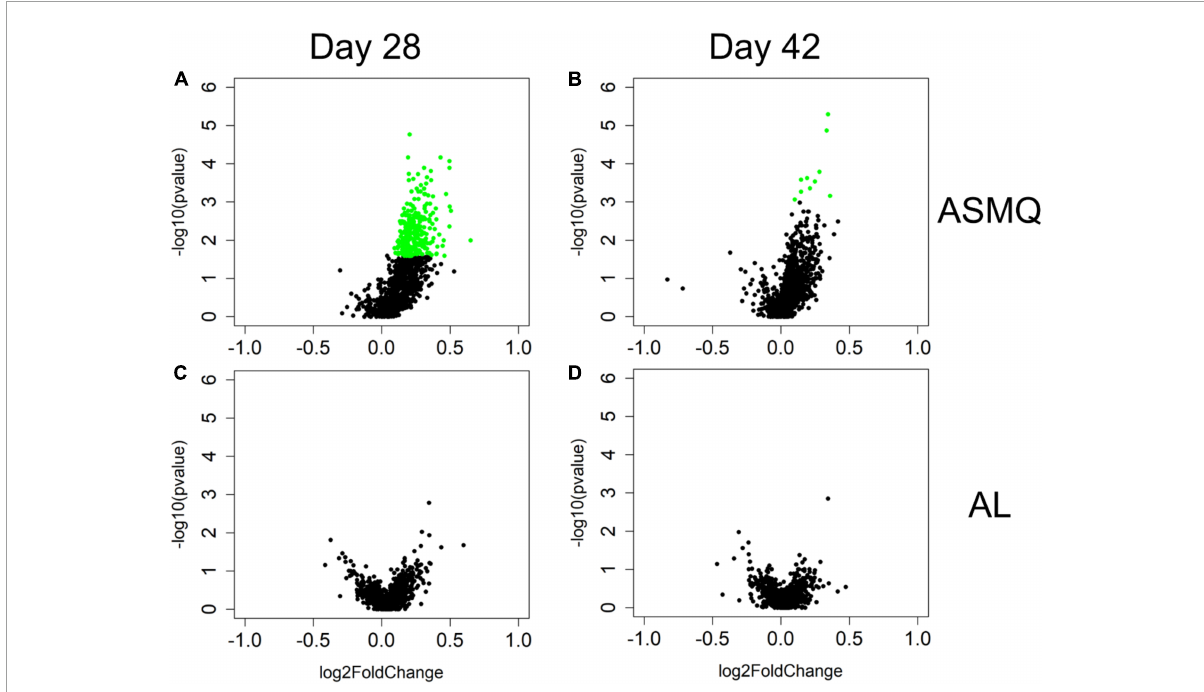
FIGURE2 nPC-ACPR-associated differences in subjects’ humoral immunity to malaria in the ASMQ and AL arms. Univariate analyses were applied to identify differences in subjects’ humoral immunity associated with ASMQ outcomes on day 28 (A) and day 42 (B) , and with AL outcomes on day 28 (C) and day 42 (D) , respectively. Volcano plots were used to present analysis results. The x -axis is log2 ratio of malaria antigen-specific antibody signals of subjects presenting nPC-ACPR to those of subjects not presenting nPC-ACPR. The y -axis is P -values based on –log10. The green dots represent the antibody responses with P < 0.05 and Benjamini-Hochberg adjusted P <